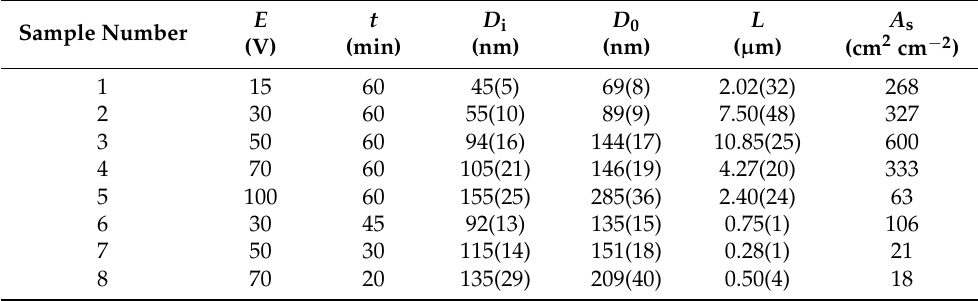
Table 1. Morphological parameters of the ONTs formed on the Ti – 6Al – 7Nb alloy in 1 M EG + 0.2 M NH 4 F electrolyte.